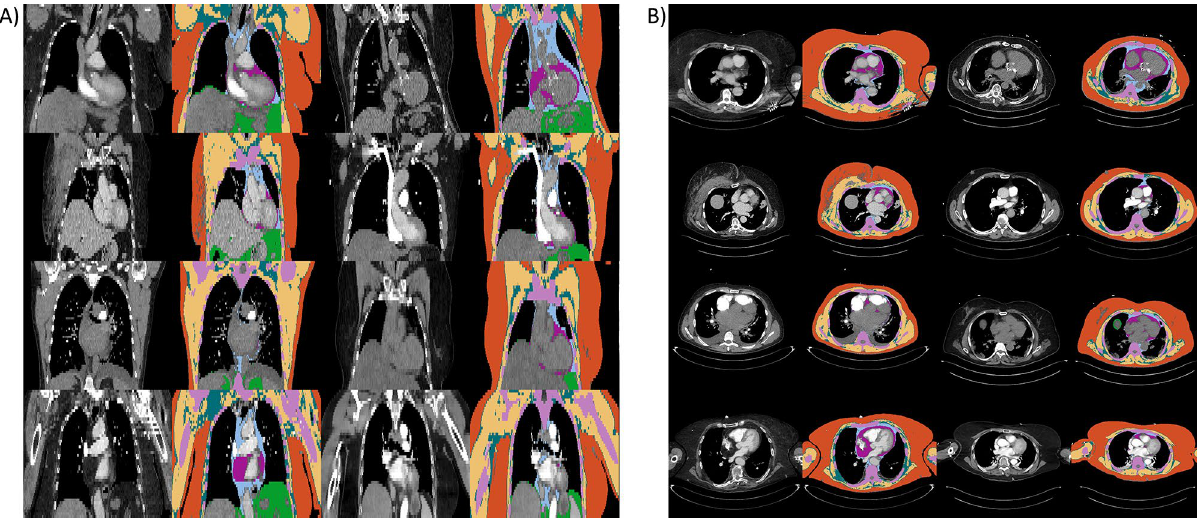
Figure 2. ( A ) Exemplary outputs of the BCA model in coronal view obtained from randomly selected patients. ( B ) Visualization of the BCA segmentations in the axial view for randomly selected patients. The tissue color codes are defined as follows : orange: subcutaneous adipose tissue, yellow: muscle tissue, cyan: intra- and intermuscular adipose tissue, pink: bone, light blue: pericardial adipose tissue, purple: epicardial adipose tissue, green: visceral adipose